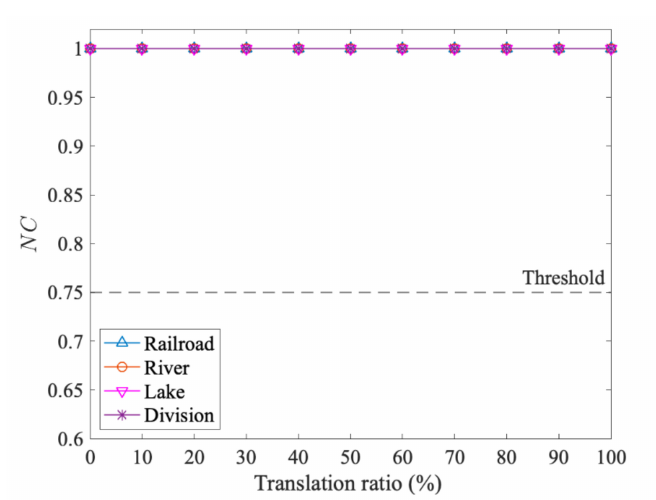
Figure 13. The results of translation